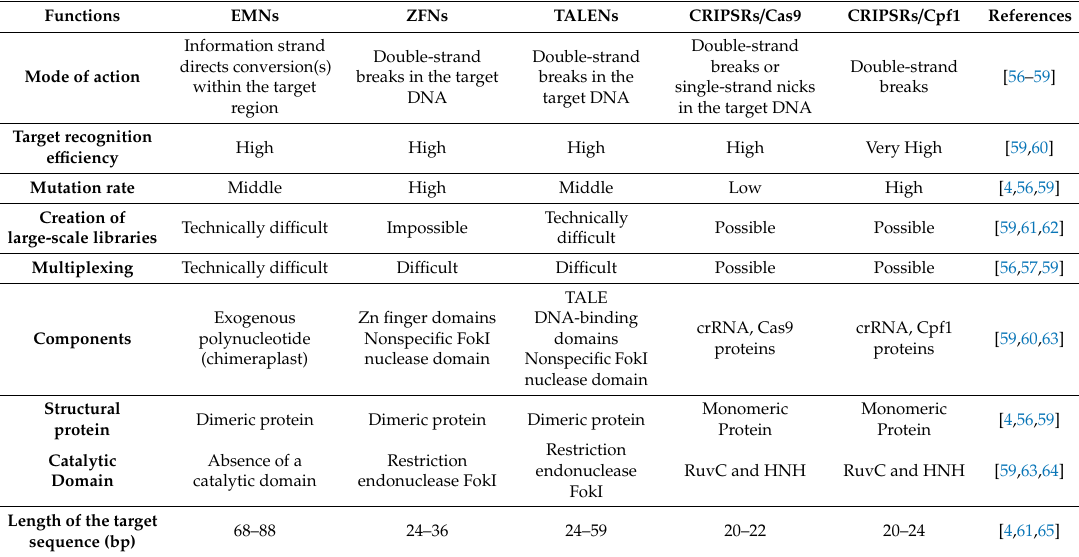
Figure 5. In a Cpf1-mediated plant genome-editing system, the T-rich region (TTTN) acts as a protospacer adjacent motif (PAM). ( a , b ) Cpf1 cleaves the target DNA and introduces double-stranded breaks (DSBs), a 5-nt potential staggered cut distal to a 5 (cid:48) T-rich PAM. ( c , d ) In Cpf1, the DSBs are subsequently repaired by two primary cellular mechanisms, nonhomologous end joining (NHEJ) and homology-directed repair (HDR). Table 1. Comparison of EMNs, ZFNs, TALENs, CRISPR / Cas9, and CRIPSR /